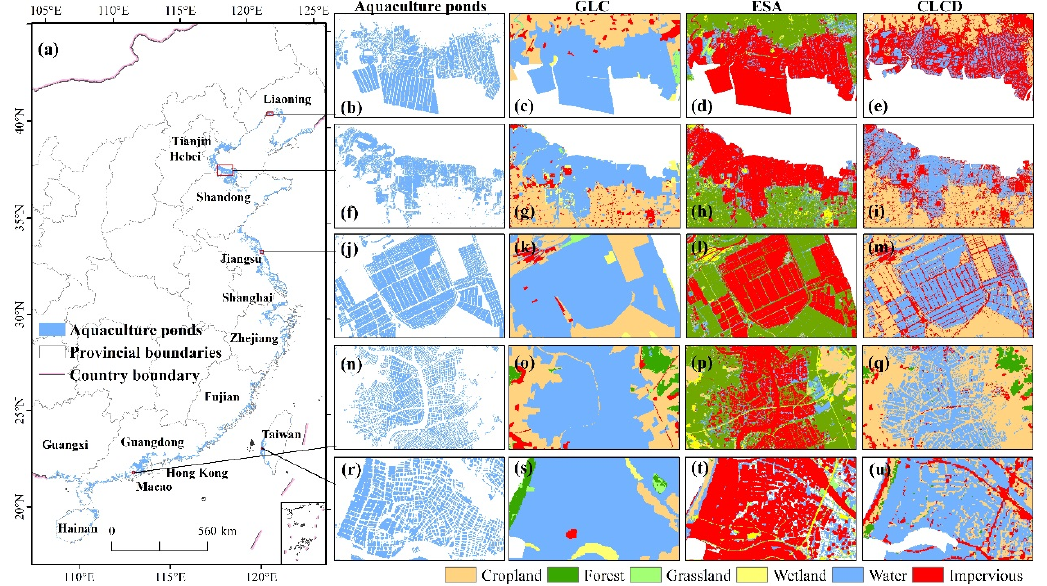
Figure 9. Comparison of our aquaculture ponds with three land cover products. (a) Spatial distri ‐ bution of aquaculture ponds; (b, f, j, n, r) distribution of aquaculture ponds in typical areas; and (c ‐ e, g ‐ i, k ‐ m, o ‐ q, s ‐ u) superimposed features of aquaculture ponds and three land cover